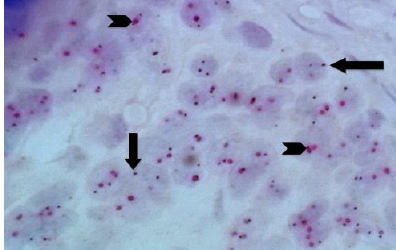
Fig. 7. Invasive Ductal Carcinoma With Non- Amplified HER2 Gene by Silver DNA in Situ Hybridization (same case in Figure 6 with higher magnification); each carcinoma cell nucleus shows (on average) an equal number of HER2 gene black SISH signals (arrows) and chromosome 17 red ISH signals (arrow heads) with a ratio of < 2